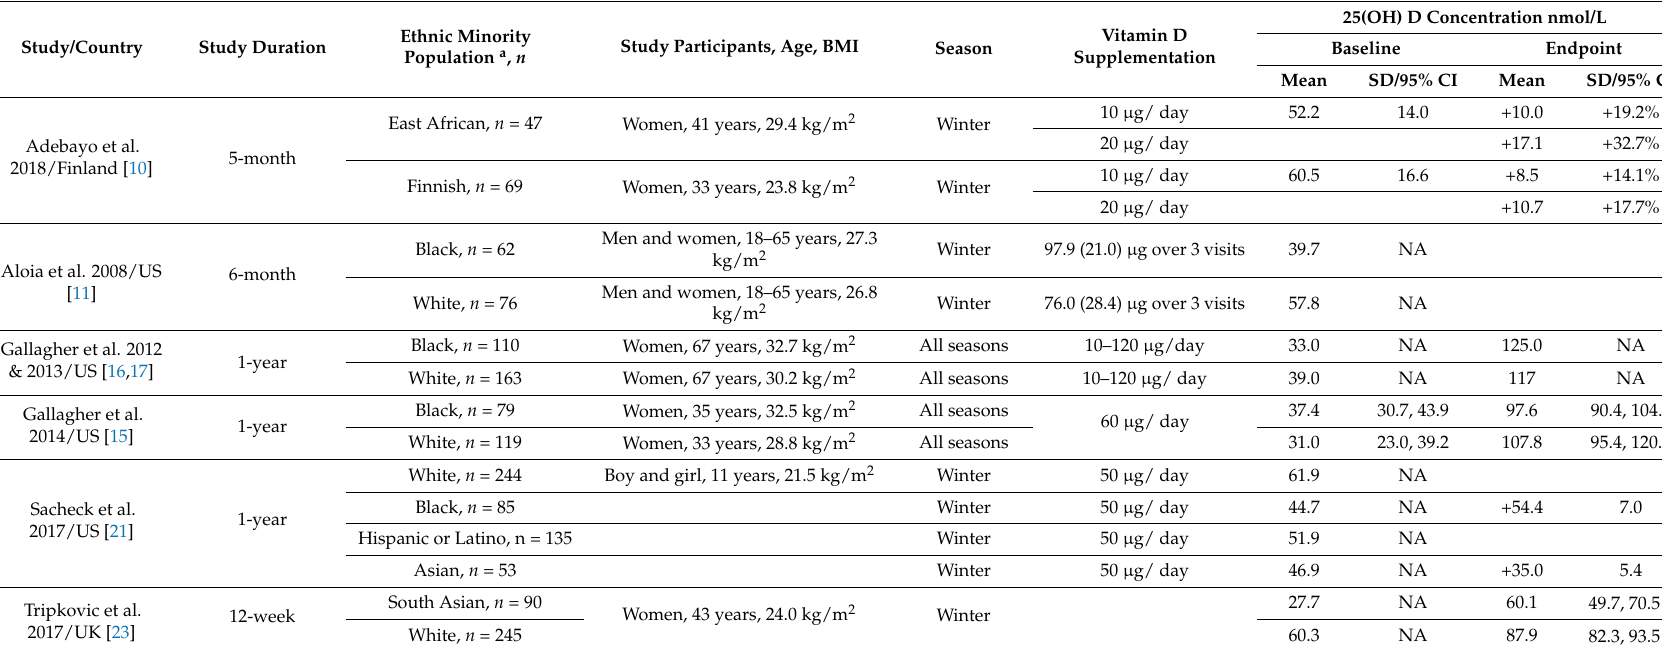
Table 2. Summary of randomised controlled trials investigating vitamin D status (25(OH)D concentration) response to vitamin D supplementation in ethnic minority population (in alphabetic